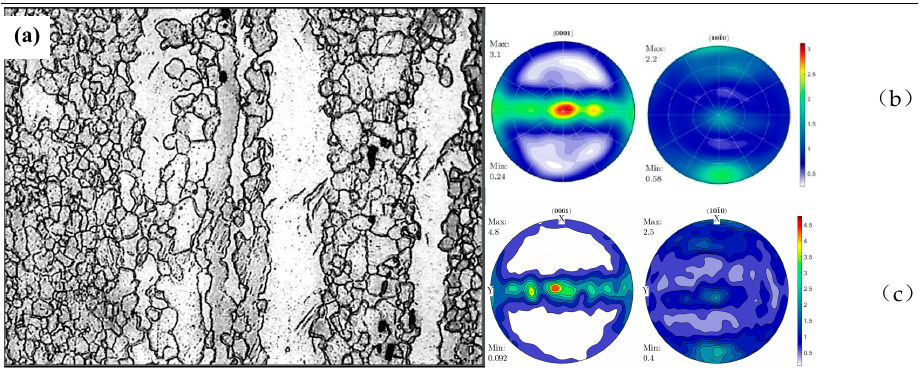
Figure 3. Initial state of AZ31 Mg extruded bar: ( a ) initial microstructure; ( b , c ): initial texture.